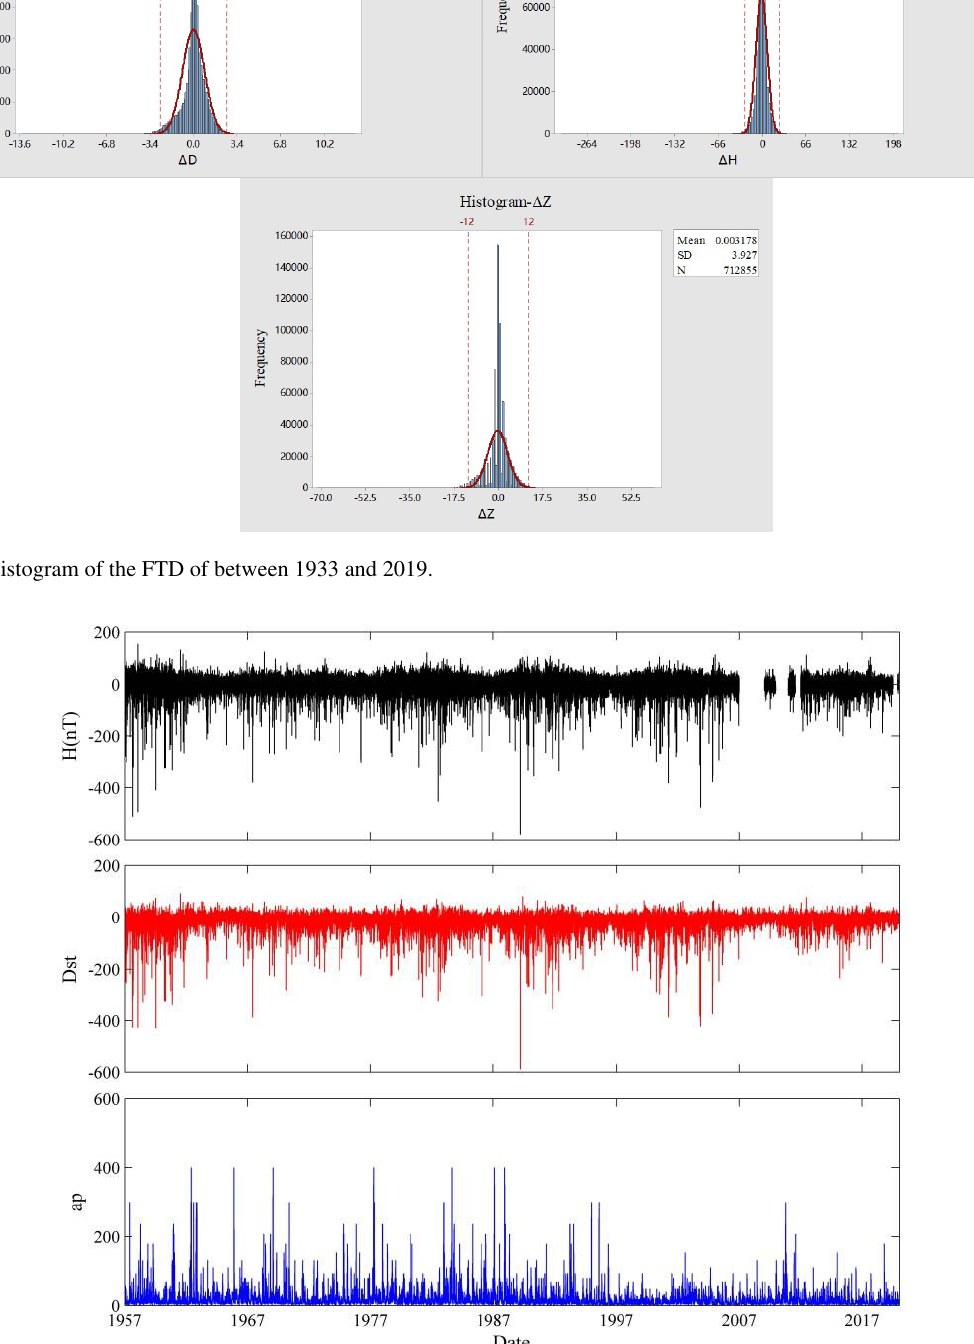
https://doi.org/10.5194/essd-14-5195-2022 Earth Syst. Sci. Data, 14, 5195–5212,